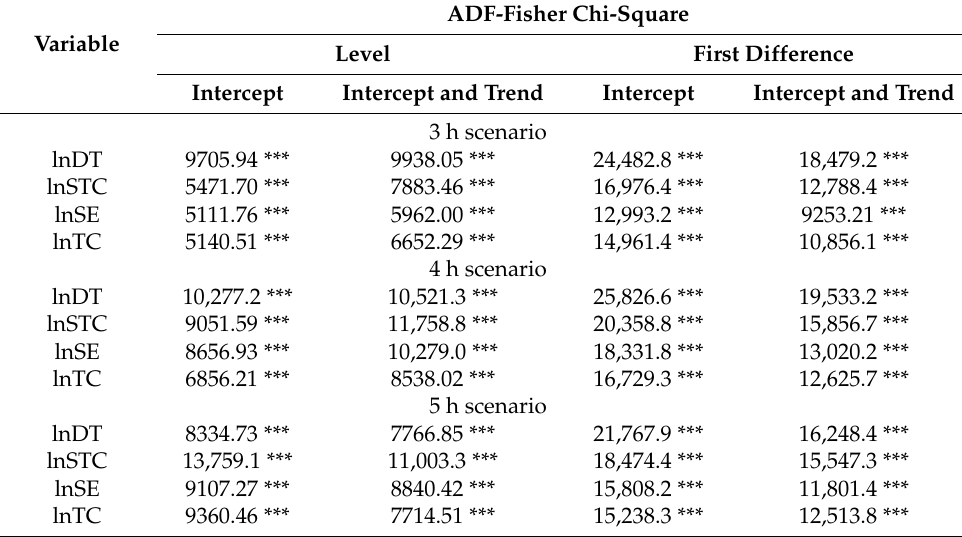
Table 2. Results of panel unit root test for different scenarios.